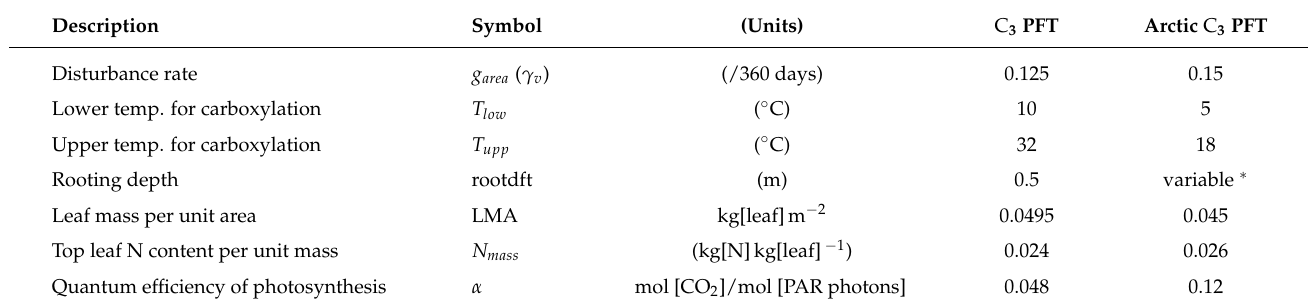
Table A1. Table of differences between the standard C 3 PFT and an Arctic (higher latitude C 3 ) PFT. ∗ The suggested root depth of the C 3 high latitude PFT is 0.2 m, but in this paper, the root depths